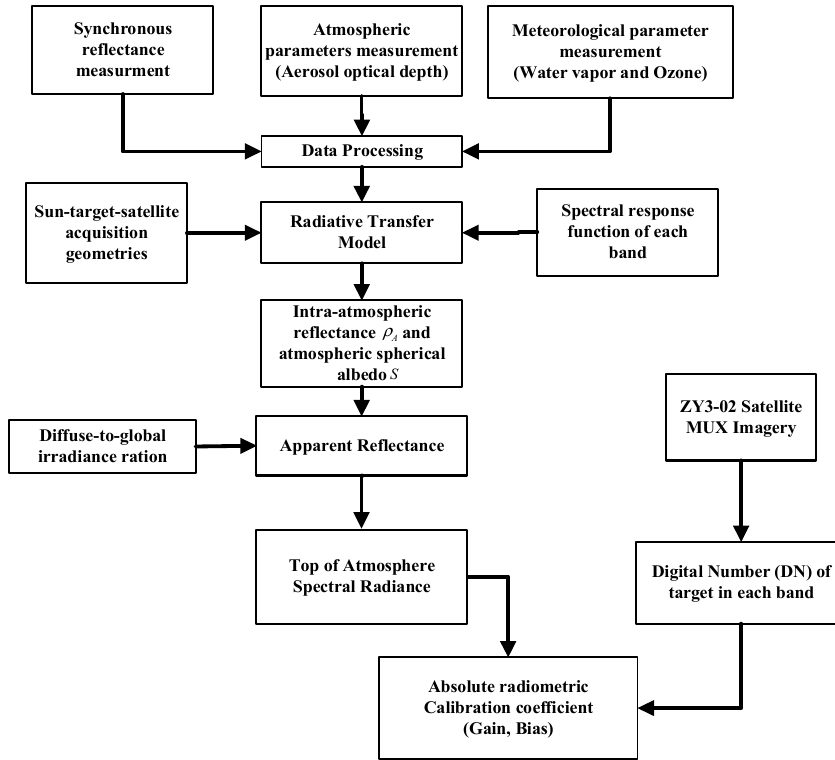
Figure 2. Technical process of on-orbit absolute radiometric calibration of multispectral sensor (MUX) based on irradiance-based method.